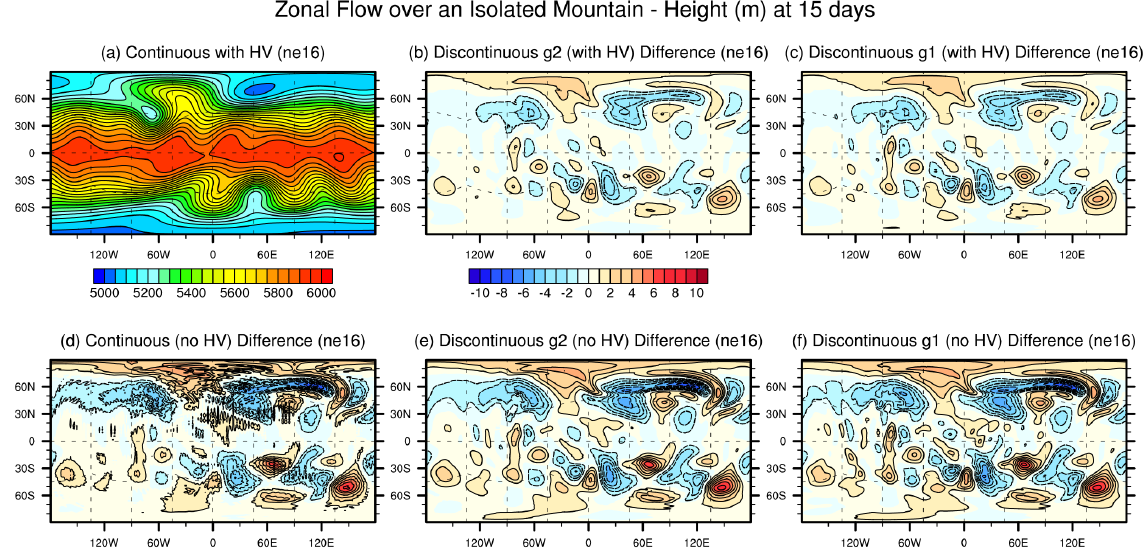
Figure 6. Height field with n e = 16 and n p = 4 at day 15 for zonal flow over an isolated mountain with (a) continuous elements and hyperviscosity (reference solution). Height difference plot from reference solution with n e = 16 at day 15 for (b) discontinuous g 2 elements with hyperviscosity, (c) discontinuous g 1 elements with hyperviscosity, (d) continuous elements without hyperviscosity, (e) discontinuous g 2 elements without hyperviscosity and (f) discontinuous g 1 elements without hyperviscosity. The time step used for these runs was (a, d) (cid:49)t = 480s, (b, e) (cid:49)t = 240s and (c, f) (cid:49)t = 120s. Discontinuous penalization was used for both discontinuous schemes. Contour spacing is 1m in all difference plots with the zero line removed. Long dashed lines show the cubed-sphere